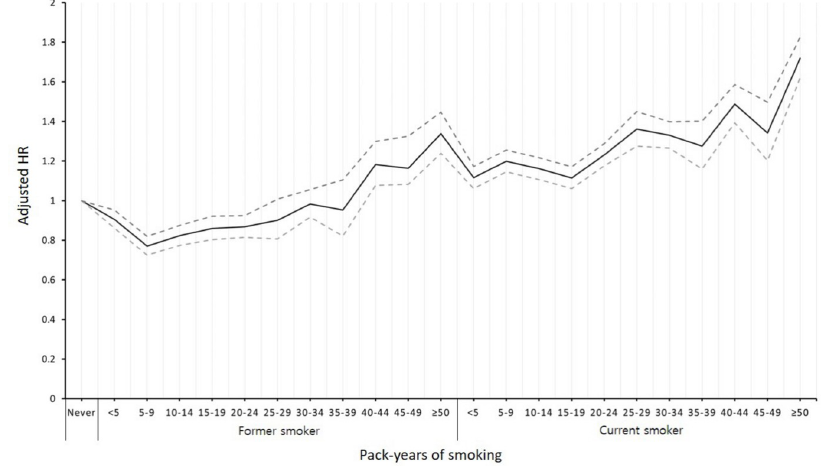
Fig 3. Risk of tuberculosis development according to the cumulative amounts of cigarettes smoked. Hazard ratios were adjusted for age, sex, alcohol consumption status, regular exercise, income level, and body mass index. Solid line indicates adjusted hazard ratios and dashed lines indicate 95% confidence interval, respectively. HR, hazard ratio.